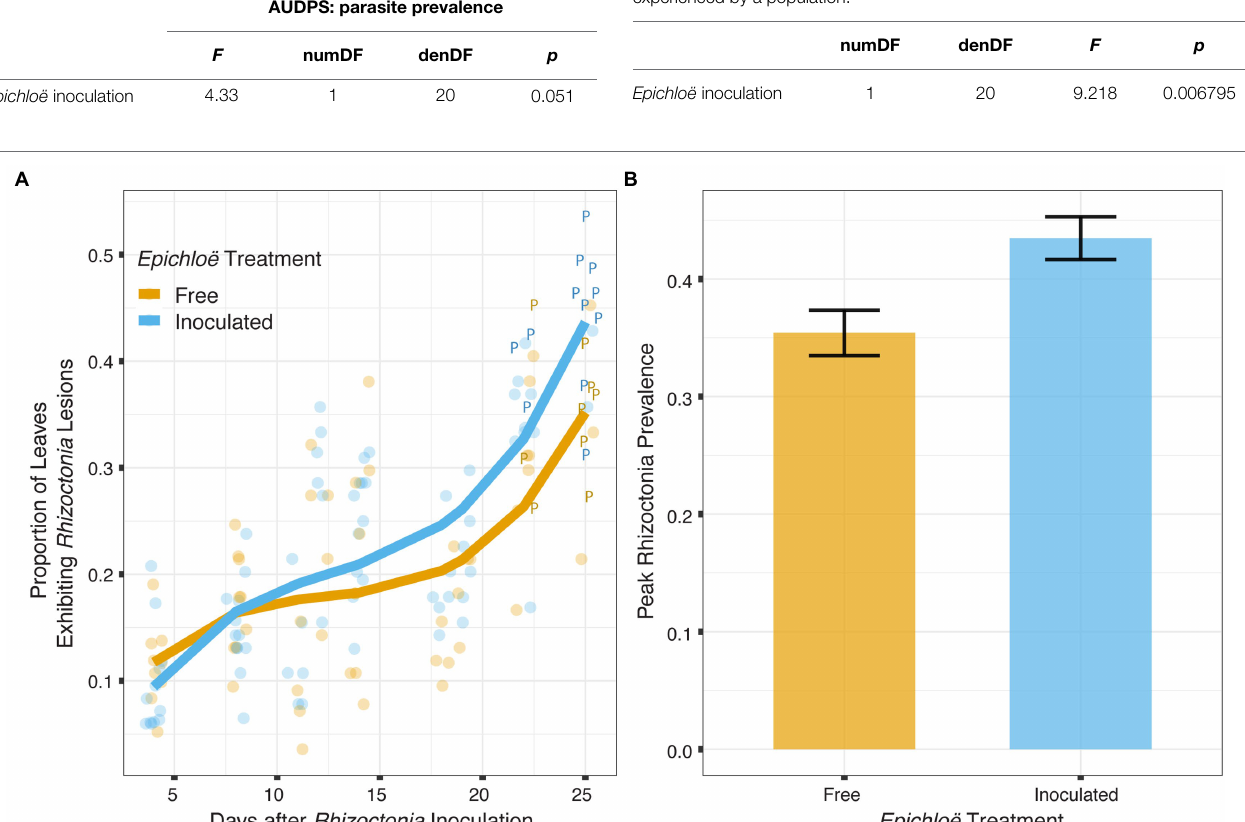
TABLE 1 | Epichloë -inoculated populations tended to have heavier disease prevalence integrated over time as log-transformed AUDPS, though this difference had weak statistical